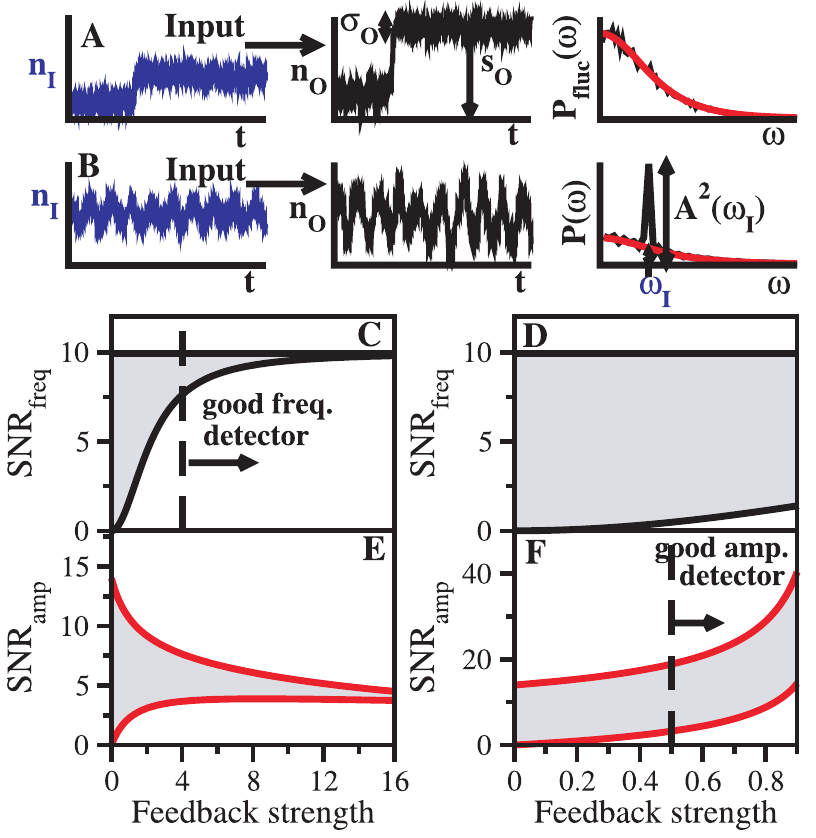
Figure 4. Quantifying signal detection with noisy components. A. Noisy amplitude detection. Left: A noisy step input acts on a detection module (also with intrinsic fluctuations). Middle: Output response characterized by susceptibility s O and amplitude of fluctuations around the equilibrium value, s O . Right: Power spectrum of fluctuations around equilibrium. Black line is the numerical computation and red line is analytical result. (B) Noisy frequency detection. Left: Oscillatory input with noise. Middle: Output response in the time domain. Right: Output response in frequency domain [total power spectrum P ( v ) ]. The height of the peak at the input frequency v I is proportional to the squared amplitude A 2 ( v I ) . The theoretical background spectrum is plotted with a red line. (C) Frequency SNR for the negative feedback module as a function of FS. The dashed line approximately marks the FS value above which deterministic frequency detection is close to optimal for this module (Figure 2A). (D) Frequency SNR as a function of FS for the positive feedback module. (E) Amplitude SNR for negative feedback. (F) Amplitude SNR for positive feedback. The region of best amplitude detection performance (more than twice the linear cascade limit, Figure 2D) is approximately delimited by the dashed line. For panels C–F, susceptibility ranges and time-scales are as in Figs. 2,3A–D. Noise strength is determined by cell volume V , and here we take V ~ 1 (Text S1).